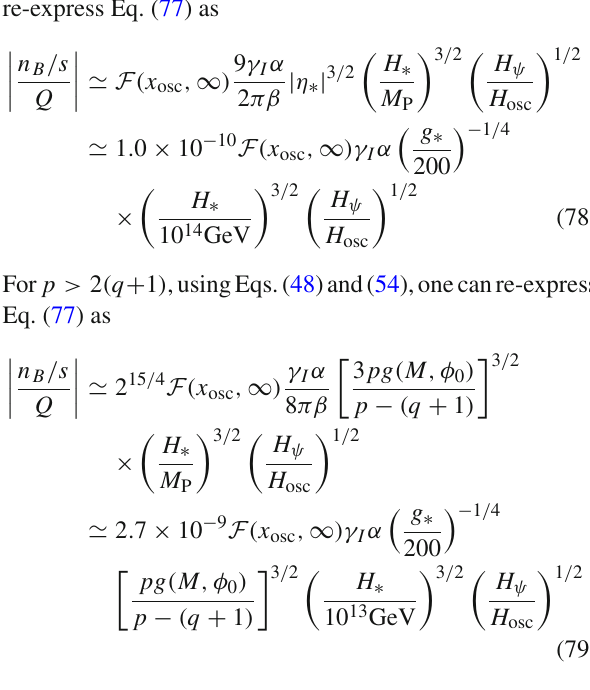
Fig. 3 Parameter space for baryon number asymmetry (red-line) as a function of M and φ 0 . Color scheme other than blue and red lines is the same as Fig. 2. The light blue and pinky regions divided by a thin light purple line are regions of H ψ > H osc and H ψ < H osc , respectively. The dashed blue line indicates parameters matching observed values of